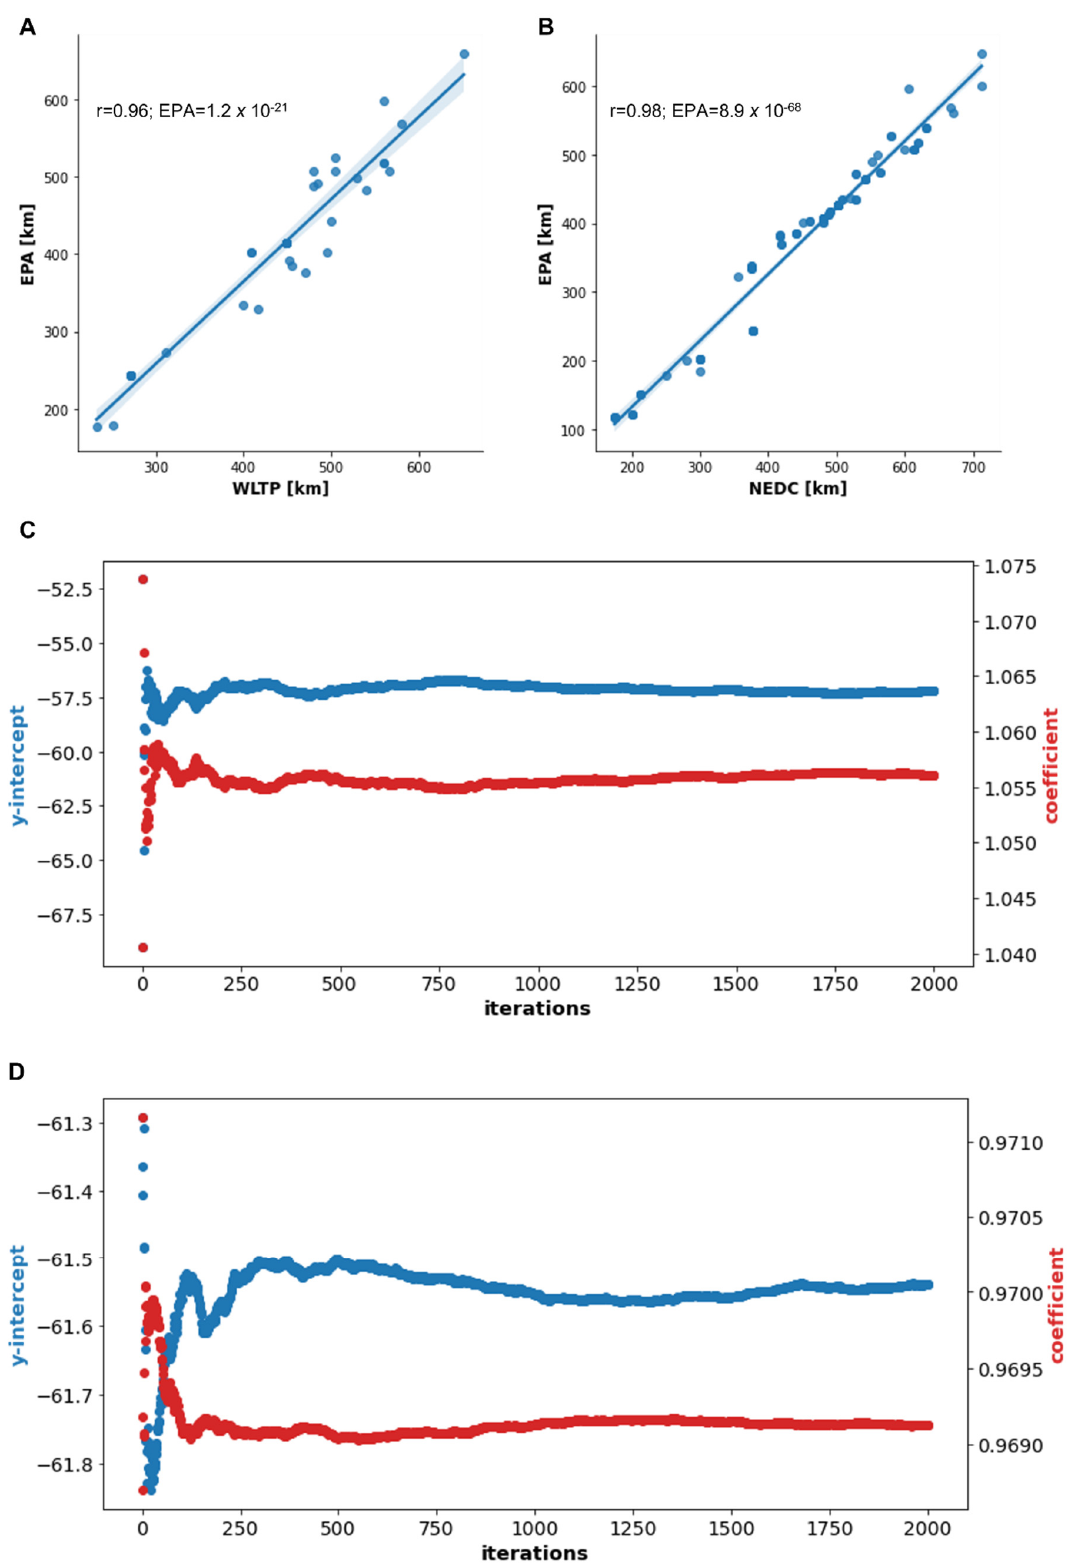
Figure 3. A plot, along with the lines of best fit and Pearson correlation coefficients between ( A ) EPA and WLTP ranges and ( B ) EPA and NEDC ranges. All units are in km. Furthermore, the bootstrapped linear regression parameters for each iteration are presented for ( C ) EPA and WLTP ranges and ( D ) EPA and NEDC